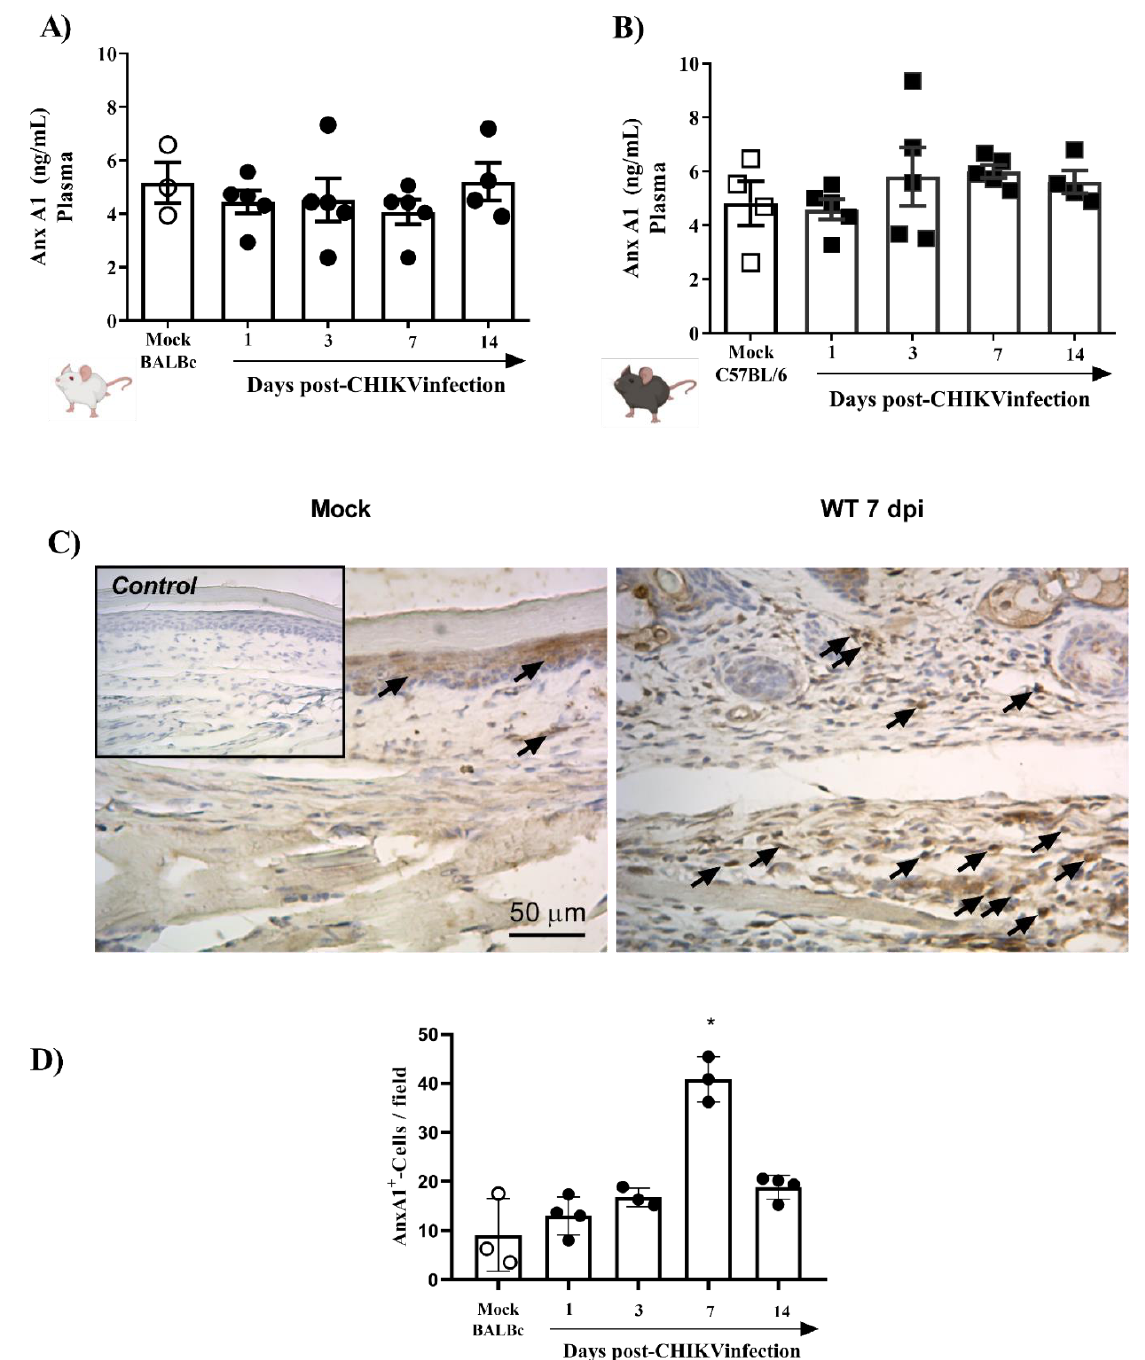
Figure 2. AnxA1 is expressed in inflamed paw tissues of CHIKV-infected mice. BALB/c or C57BL/6 mice were infected through the intraplantar (i.pl.) route with CHIKV 10 6 PFU and were euthanized at 1, 3, 7 or 14 days post-infection. Paws were collected and processed for analysis of AnxA1 expression by immunohistochemistry (IHC), and the plasma was used to measure AnxA1 levels. ( A ) AnxA1 levels in the plasma of BALB/c mice, ( B ) AnxA1 levels in the plasma of C57BL/6 mice. Results are represented as ng of AnxA1 per mL of plasma. ( C , D ) Score and representative AnxA1 IHC images of an inflamed joint footpad. IHCs were quantified as the average of positive cells in five independent fields per tissue at 400 × . Statistical analysis was performed using the Kruskal–Wallis with Dunn’s comparisons test. Data were presented as mean ± SEM (number of animals is shown in each graph); * p < 0.05 when compared with control uninfected mice (mock).